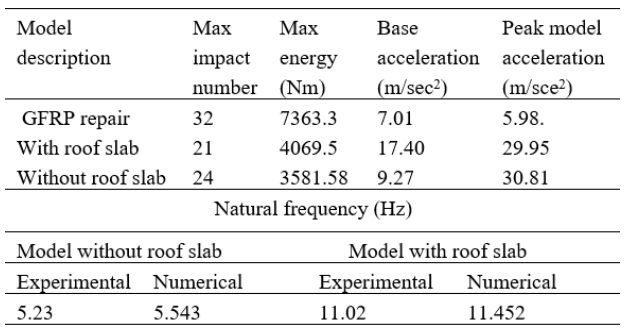
Dynamic characteristics of RTB masonry